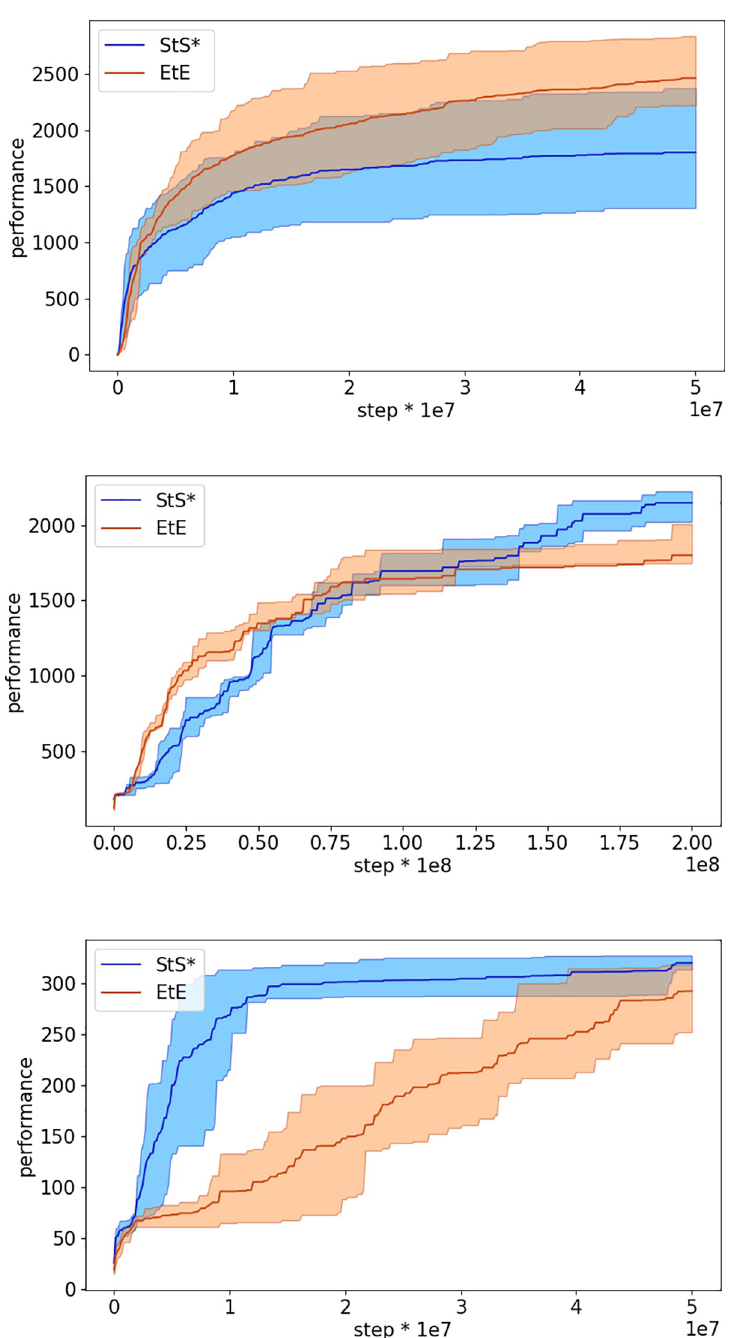
Fig 5. Performance of the sequence to sequence condition in the continuous training modality (StS � ) and of end- to-end condition (EtE) during the evolutionary process in the case of the HalfCheetahBullet, BipedalWalkerHardcore, and MIT racecar problems (top, middle and bottom figures, respectively). Performance refer to the average fitness of the best agent achieved so far. Data computed by post-evaluating the best individual of each generation for 3 episodes in the case of MIT racecar and HalfCheetahBullet and for 20 episodes in the case of the BipedalWalkerHardcore. Mean and 90% bootstrapped confidence intervals of the mean (shadow area) across 10 replications per